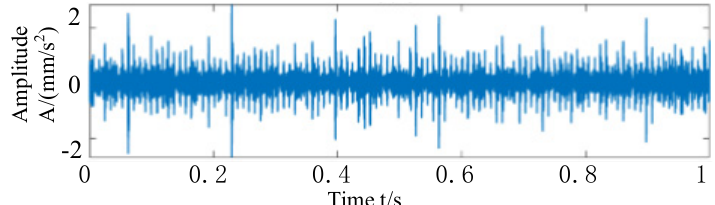
Figure 19. Filtered signal Time-domain waveform.